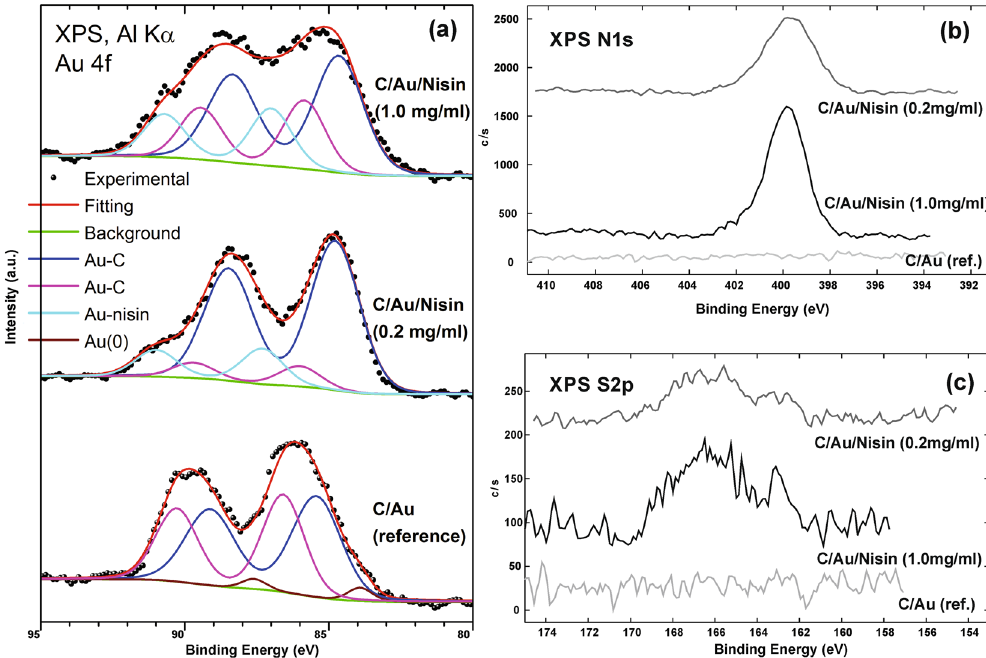
Figure 4. Elemental composition analysis at the surface of the C/Au. The Au 4 f ( a ), N 1 s ( b ) and S2p ( c ) spectra of the C/Au reference and C/Au/nisin functionalized with lower (0.2 mg/ml) and higher (1 mg/ml) content of the